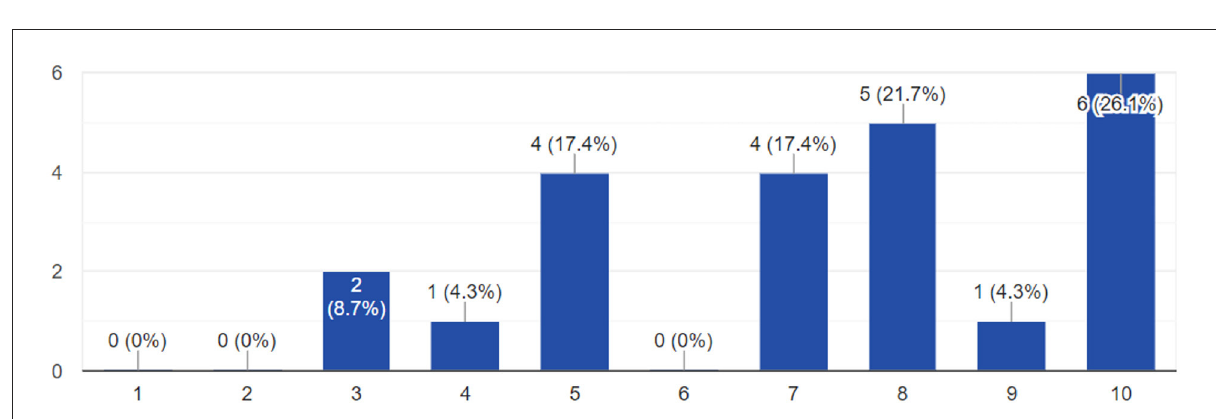
FIGURE13 Public reaction to EU econometric loss (1 is less than expected, 10 is